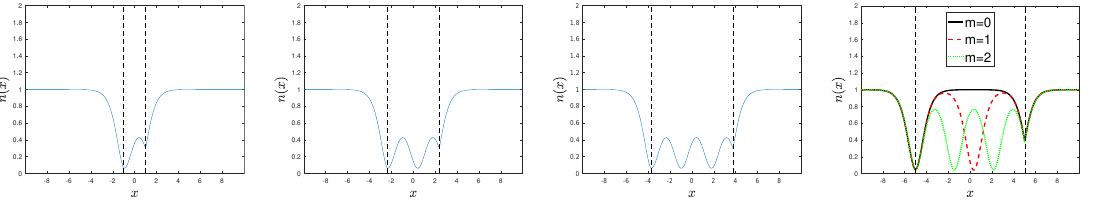
Figure 7. Density profile of the asymmetric solutions for the double-delta configuration. The vertical dashed lines mark the limits of the cavity. Leftmost panels: m = 0,1,2 AC solutions for v = 0.2 and X = 2,4.76,7.51, respectively. Rightmost panel: m = 0,1,2 AD solutions for v = 0.2 and X =